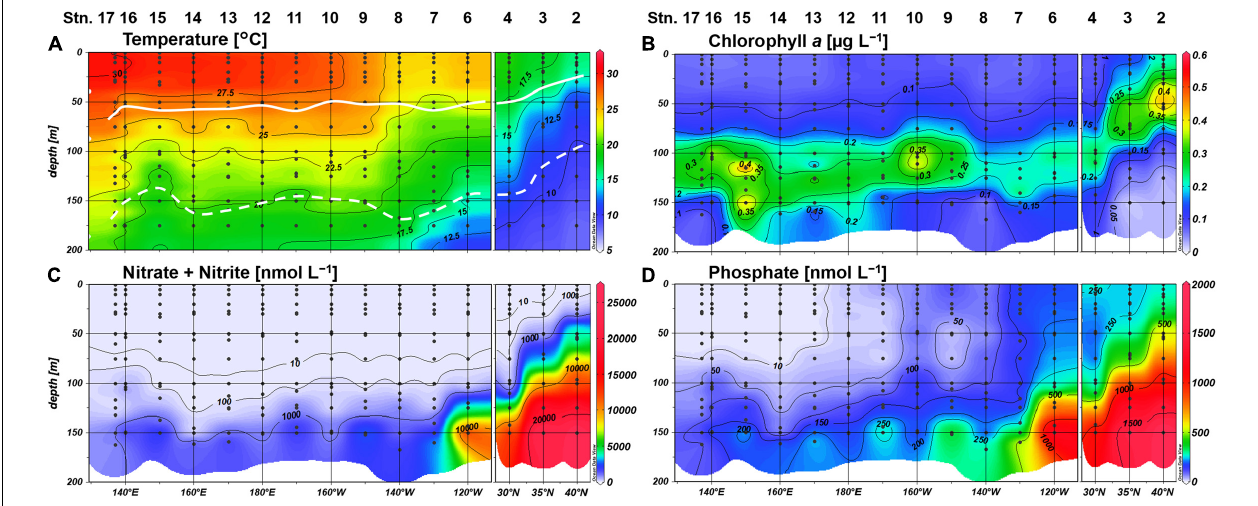
FIGURE 3 | Distributions of the cell abundances of (A) heterotrophic bacteria, (B) Prochlorococcus , (C) Synechococcus , (D) nanoeukaryotes, and (E) picoeukaryotes.